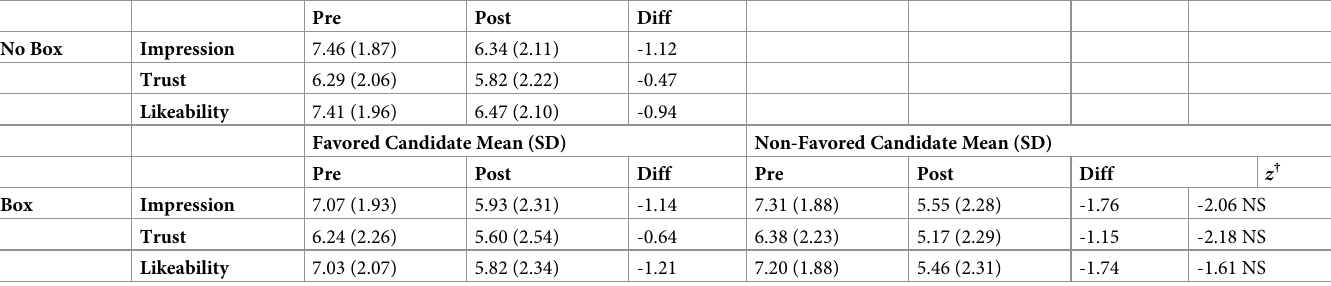
Table 4. Experiment 2: Pre- and post-search opinion ratings of favored and non-favored